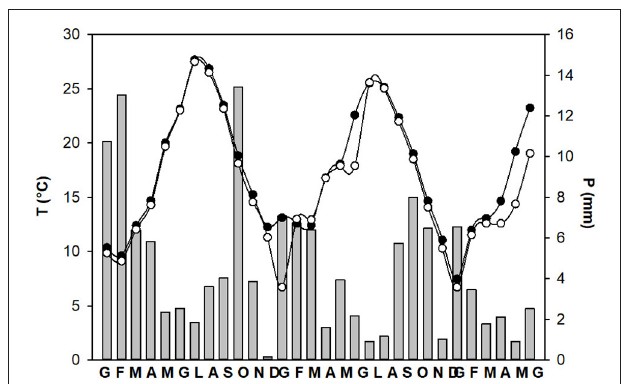
FIGURE 1 | Monthly mean of temperature (T, expressed as ◦ C) and precipitation (P, expressed as mm) values of north (filled symbols and bars) and south (empty symbols and bars) slopes related to the study area from January 2015 to June